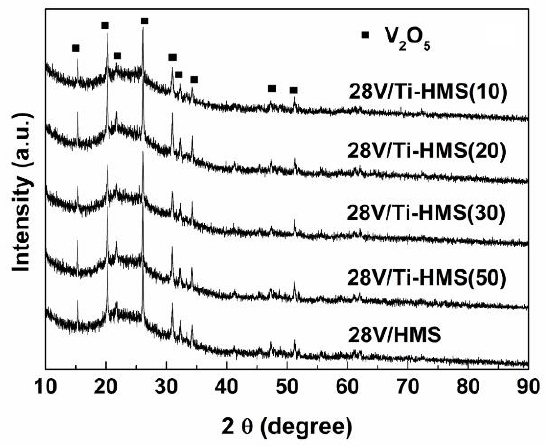
Figure 2. XRD patterns of catalysts with different supports.